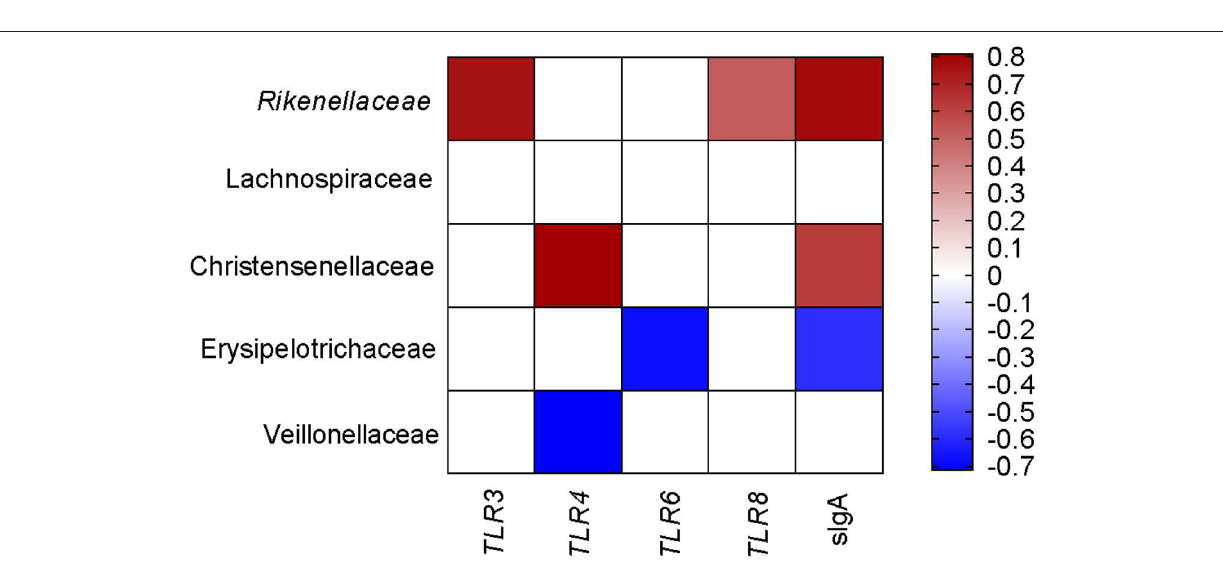
FIGURE 5 | Correlation analysis between colonic microbial composition and genes related to blood immunity and sIgA, which were significantly influenced by the FF diet in the colonic of pigs compared to the Ctrl diet. Ctrl, pigs fed with normal commercial feed; FF, pigs fed with fermented meal. The color represents a significant correlation ( P < 0.05), and the intensity of the colors represents the degree of association. Red represents significantly positive correlation and blue represents significantly negative correlation ( n =